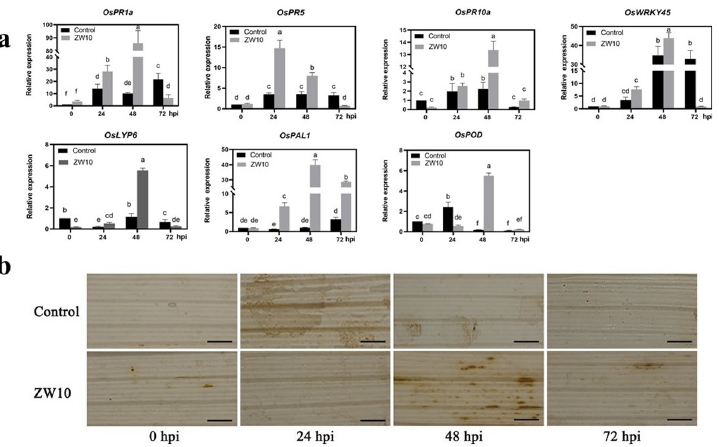
Fig 5. The antifungal substances of ZW10 induced rice capacity to resist M . oryzae . The expression of relevant defense genes in rice leaves after inoculation with 1% CFB of ZW10 (a), and differential content of H 2 O 2 as indicated by diaminobenzidine (DAB) staining (b). Data are presented as means of three replicates ± SD. Means with different letters have significant differences (P < 0.05). Scale bar, 50 μ m. (SA) signaling pathway [33]. As shown in Fig 5A, the defense genes of rice were activated to varying degrees from 24 hpi to 72 hpi. The expression of defense genes in rice treated with 1%